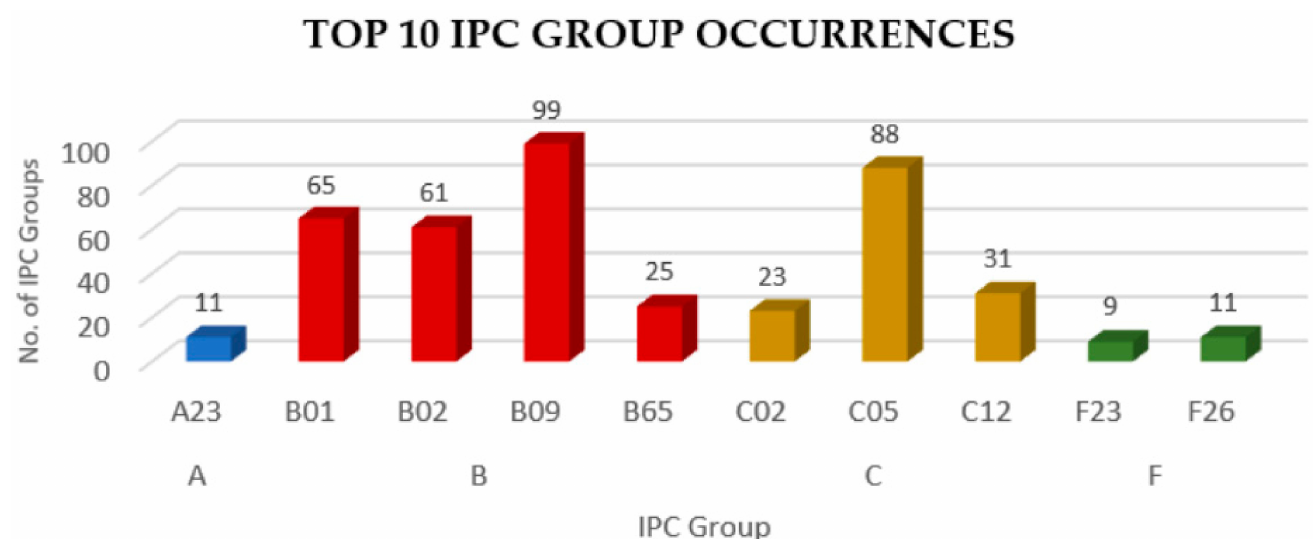
Figure 11. Frequency of top-ten IPC group